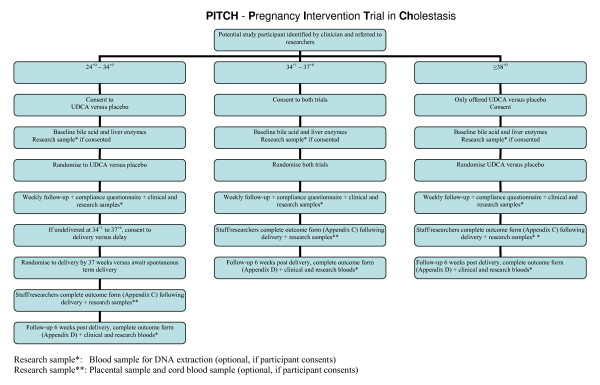
Flow of trial participants from recruitment to six weeks follow-up after delivery.